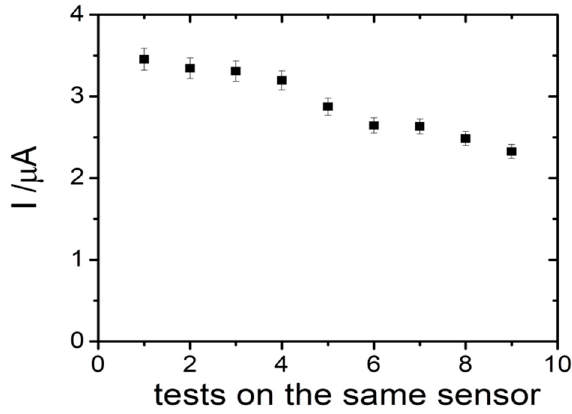
Figure 7. The reusability tests for the PyoV sensor.